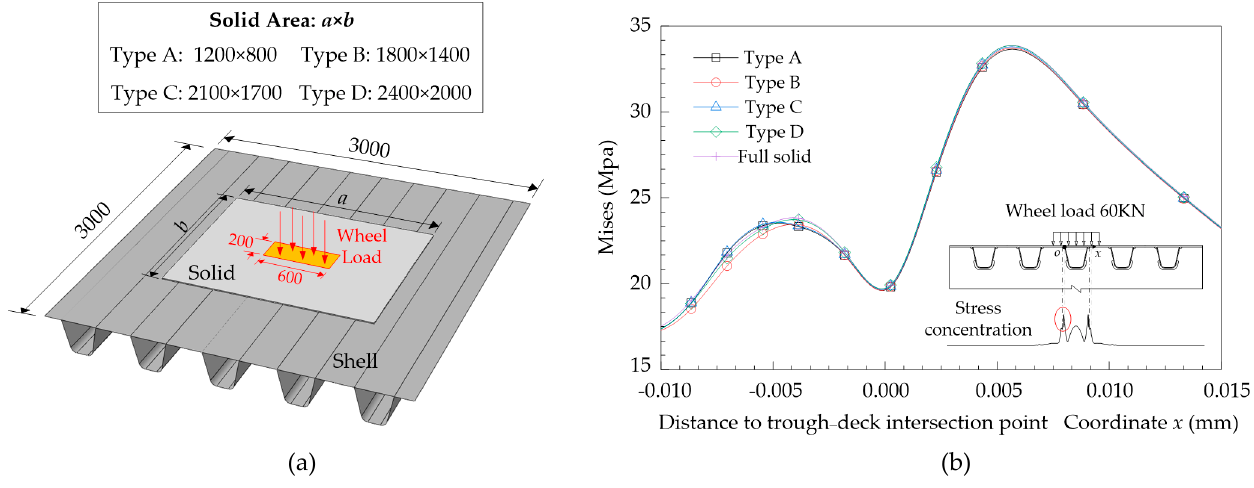
Figure 6. Convergence verification: ( a ) influence of different solid area; ( b ) validation model (unit: mm).